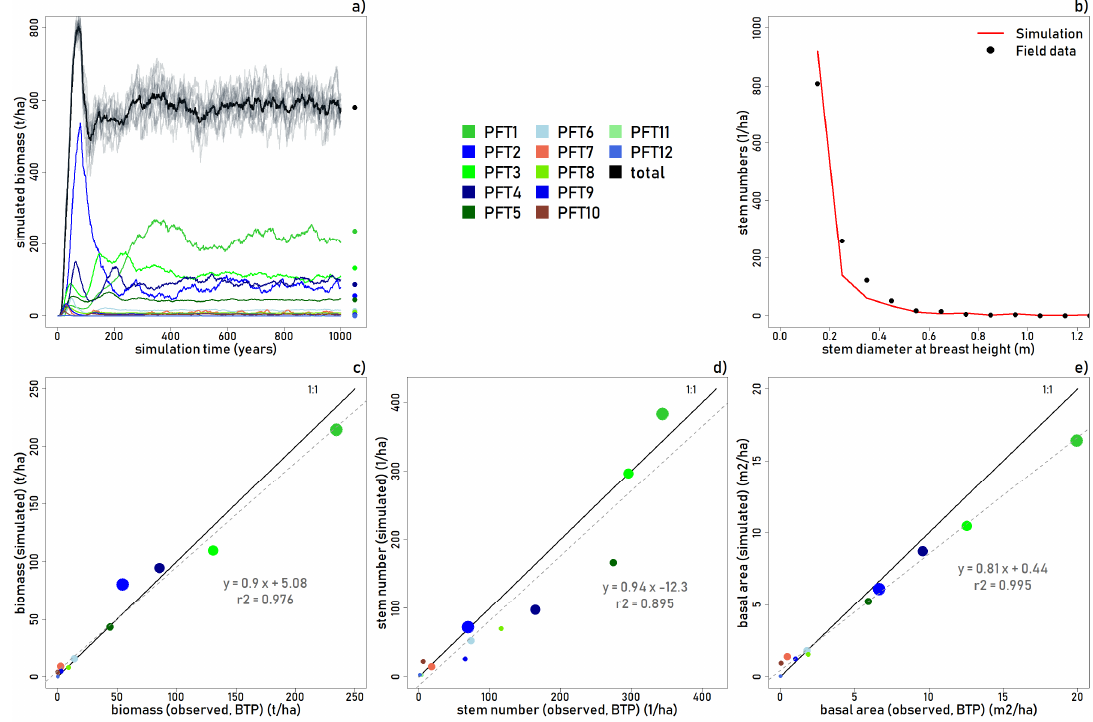
Figure 3. ( a ) Aboveground biomass time series for 50 stochastic FORMIND runs from bare ground (each 1 ha) in grey, with the average of those runs in black. The colored lines are averaged time series simulated biomass corresponding to the plant functional types (PFTs) keyed in the middle. Dot colors correspond to shade tolerance class, with shade tolerant PFTs in green, intermediate tolerance in blues, and shade intolerance in reds. The dots to the far right of the figure are the aboveground biomass values calculated from the Betampona (BTP) inventory plots in colors corresponding to PFT, with total in black; ( b ) This figure shows the stem number for each stem diameter class, with the BTP inventory plot data values as black dots, and the simulation values as a red line; ( c ) Measured aboveground biomass vs. simulated aboveground biomass (tC/ha) by PFT. Dot colors correspond to shade tolerance class, with shade tolerant PFTs in green, intermediate tolerance in blues, and shade intolerance in reds. Dot size corresponds to size class, ranging from canopy emergent (largest) to woody treelet (smallest); ( d ) Observed stem numbers in BTP vs. FORMIND simulated stem numbers. As with plot ( c ), dot size and color correspond to size class and shade tolerance; ( e ) Measured (BTP) vs. simulated basal area (m 2 /ha) per hectare. As with plots ( c ) and ( d ), dot size and color correspond to size class and shade tolerance.